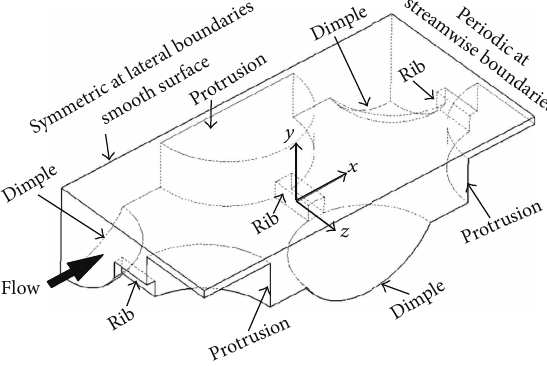
Figure16:Rib,dimple,protrusionarrangement,illustratingdomain for numerical analysis, employed in the investigation by Murata et al.